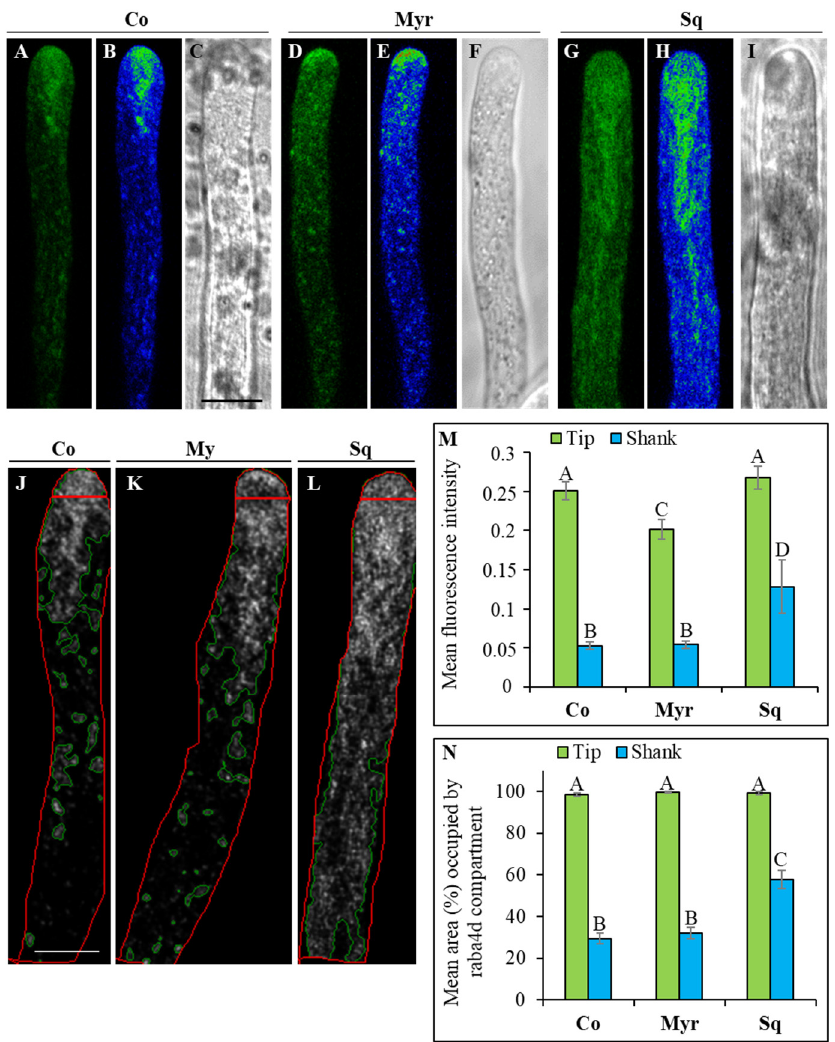
Figure 10. Analysis of morphology and dynamics of the clear zone. Pollen tubes were transiently transformed with LAT52-GFPRabA4d. In control cells, RabA4d localized on vesicles accumulating in the clear zone with the characteristic V-shaped morphology (( A ) LAT52-GFPRabA4d; ( B ), pseudo-colors, ( C ) bright field). In myriocin-treated pollen tubes vesicles appear mostly concentrated in the tip dome (( D ) LAT52-GFPRabA4d; ( E ), pseudo-colors, ( F ) bright field). With squalestatin an expansion of the clear zone with the V-shape extending more deeply from the tip to shank/distal regions is observed (( G ) LAT52-GFPRabA4d; ( H ) pseudo-colors, ( I ) bright field). For quantitative analyses, ROIs in red define either the first 5 μ m of pollen tube tip or the following 60 μ m along shank and distal regions ( J – L ). In each ROI, the % of area occupied by RabA4d (defined by the green line) and the mean intensity for each condition were quantitatively analyzed (( J – L ) for control, myriocin and squalestatin, respectively; n > 14). Myriocin induces a significant reduction in mean fluorescence intensity in the tip (( M ); ANOVA and Tukey’s post hoc test: p < 0.001) and a significant increase in the mean area occupied by RabA4d compartments (( N ); ANOVA and Tukey’s post hoc test: p < 0.01) with respect to control tubes. Squalestatin induced, in shank and distal regions, a significant increase in mean fluorescence intensity (( M ); ANOVA and Tukey’s post hoc test: p < 0.01) and of the area occupied by RabA4d compartments (( N ); ANOVA and Tukey’s post hoc test: p < 0.01). Scale bars = 10 μ m.